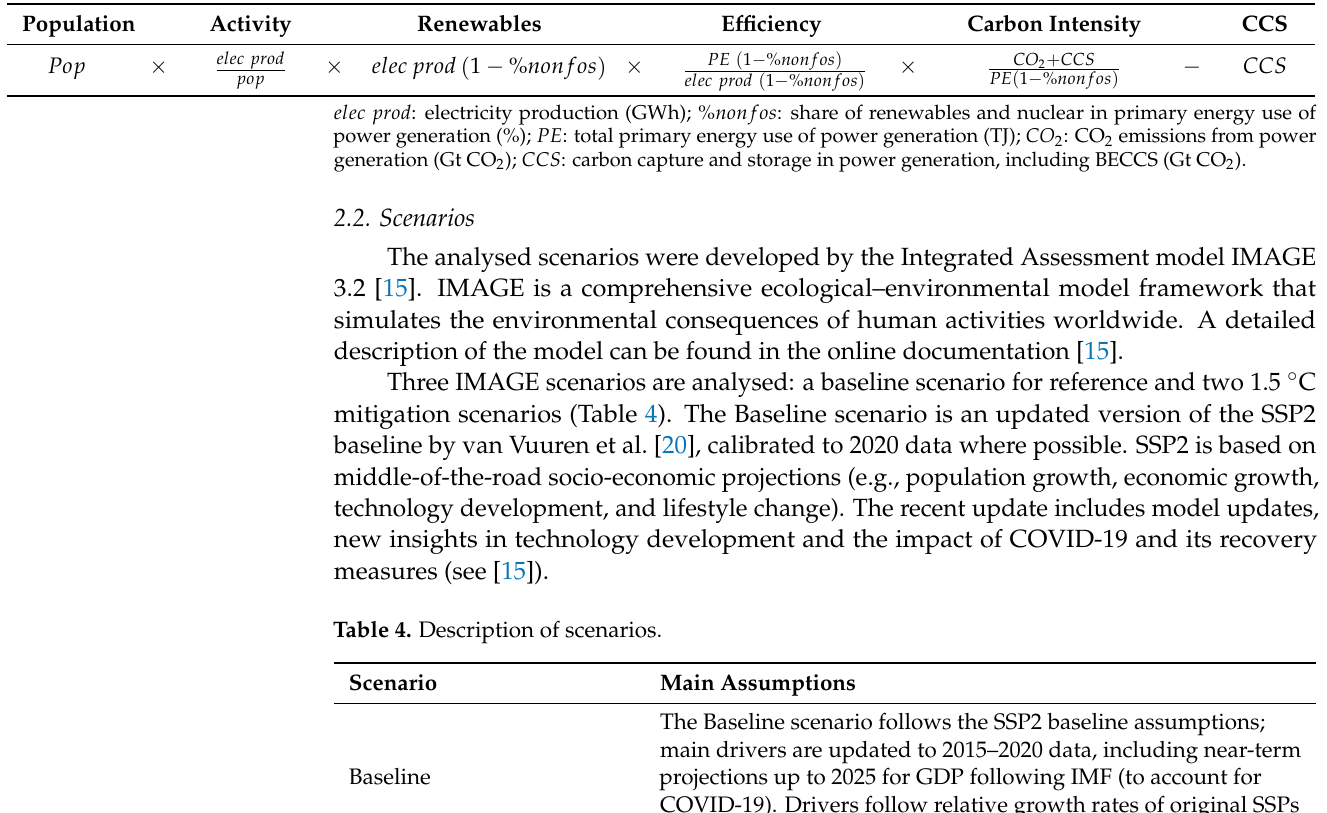
Table 3. Decomposition formula for power generation.